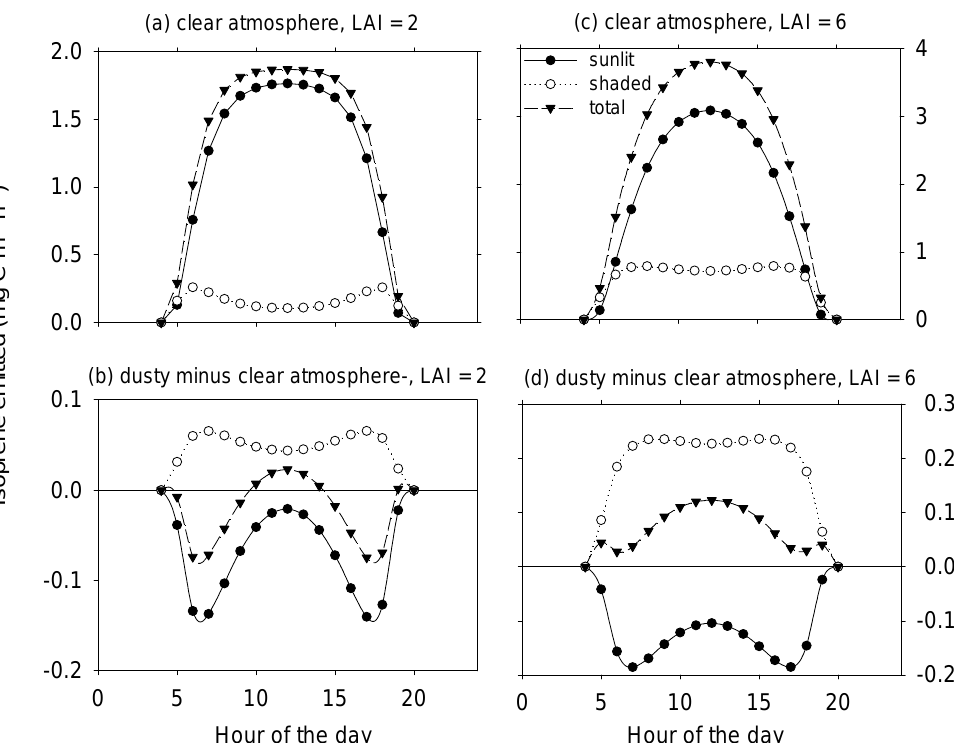
Fig. 5. Hourly variation in sunlit and shaded isoprene emission for 1m 2 and changes in those emissions produced by going from a clear to dusty atmosphere. (a) and (b) for LAI=2, isoprene emissions in clear atmosphere, and emission changes due to dusty atmosphere, respectively. (c) and (d) are the corresponding plots for